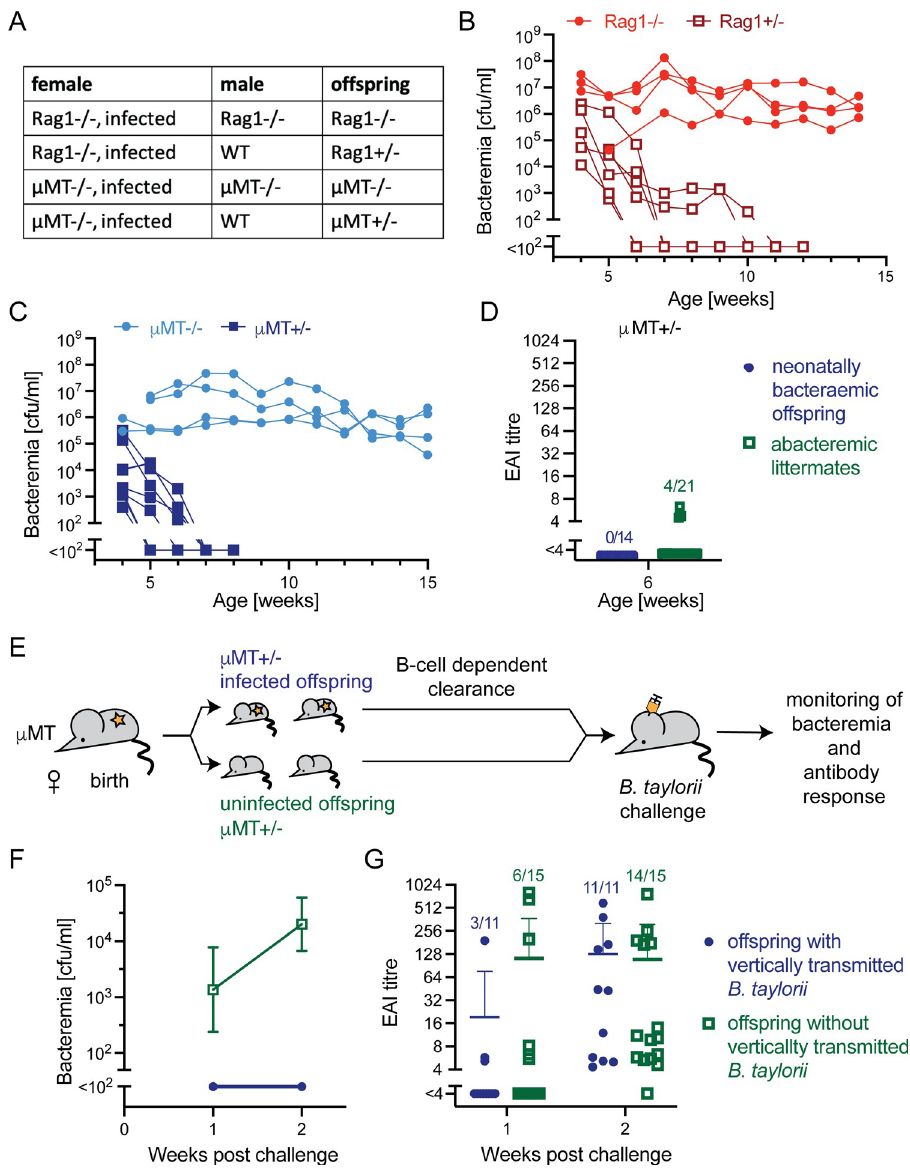
Fig 3. Immunocompetent offspring clear vertically transmitted Bartonella infection and develop protective immunity to re-infection. (A) Schematic overview of homozygous (immunocompromized) and heterozygous (immunocompetent) crosses between infected Rag1-/- or μ MT dams and uninfected males of the indicated genotypes. Female mice were infected i.d. with 10 7 cfu of B. taylorii and were mated continuously with either WT, Rag1-/- or μ MT-/- males. (B-C) Bacteremia of immunocompetent ( μ MT+/-, Rag1+/-) and immunocompromised ( μ MT-/-, Rag1-/-) pups born to Rag1-/- (B) and μ MT (C) mothers. (D) The antibody response of immunocompetent μ MT +/- offspring at 6 weeks of age was determined by means of an erythrocyte adhesion inhibition (EAI) assay [9], comparing animals with vertically transmitted B. taylorii infection and uninfected litter mates. (E) Schematic overview for the challenge experiment presented in (F-G): Offspring infected with B. taylorii by vertical transmission were re- challenged with with 10 7 cfu of the same bacterial strain after they had cleared the congenital infection. Litter mates without detectable vertical B. taylorii infection served as controls. Bacteremia (F) and EAI antibody titers (G) were determined at the indicated time points. The data represents pooled results from: (B) 10 animals (4 Rag1-/- and 6 Rag +/-), (C) 13 animals (4 μ MT -/- and 9 μ MT +/-), (F-G) 26 animals (11 with congenital infection, 15 without congenital infection). Numbers above symbols in (D, G) indicate the number of animals with EAI antibody titers above technical cut-off/number of animals tested. Symbols in (B, C, D, G) show individual mice, data points in (F) represent the mean ± SD of 14 and 8 animals, respectively.